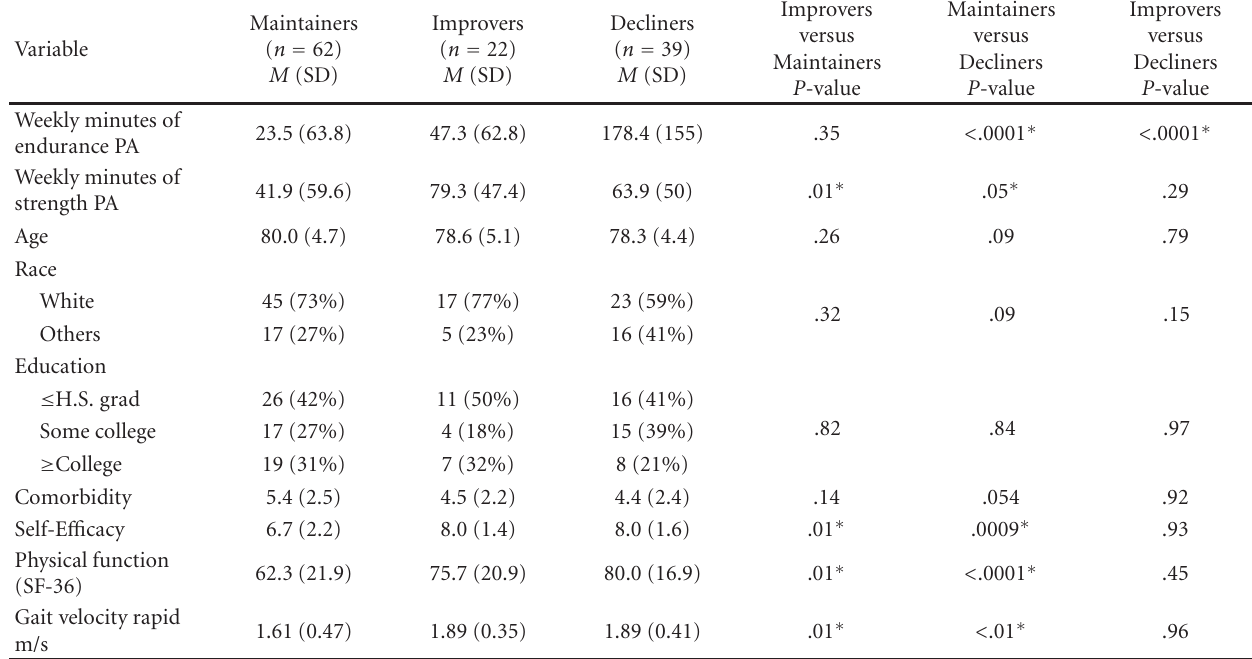
Table 2: Characteristics of maintenance, improvement, and decline from 12 to 24 months: minutes of moderate-intensity endurance PA.